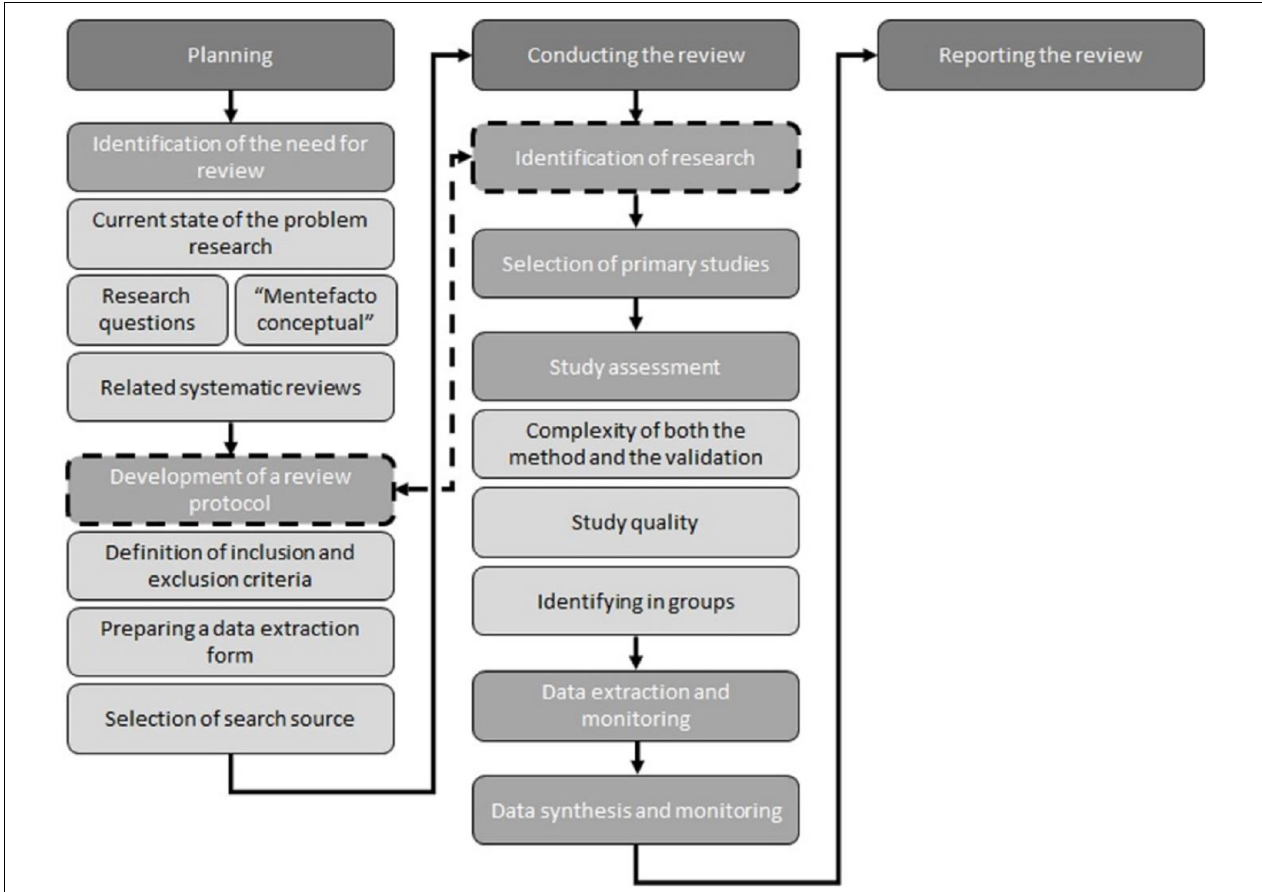
FIGURE 1 | Flowchart of the